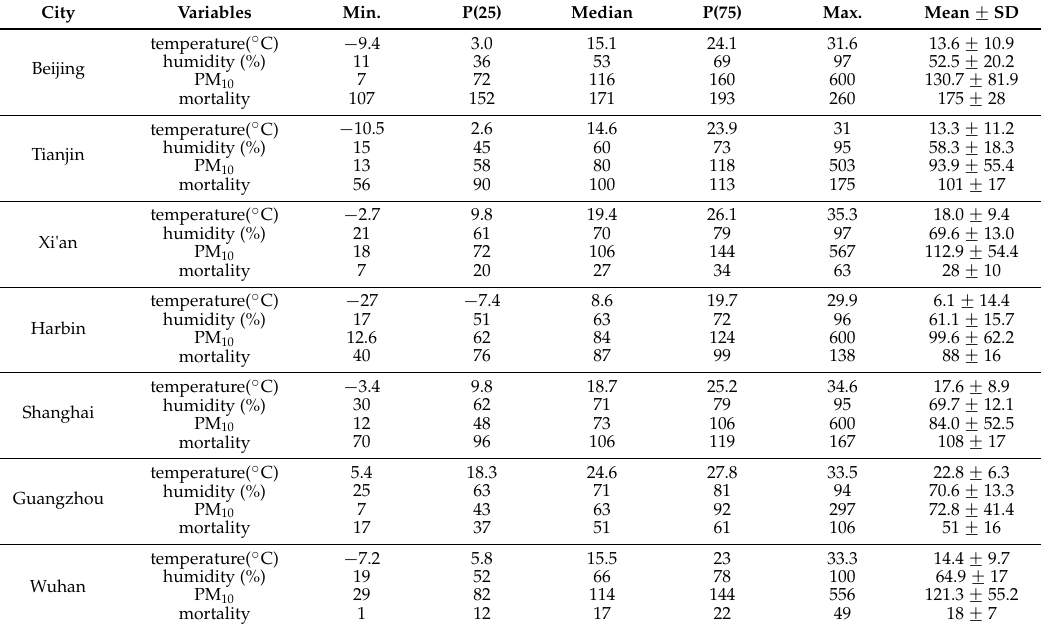
Table 2. Summary statistics of the variables of seven large cities in